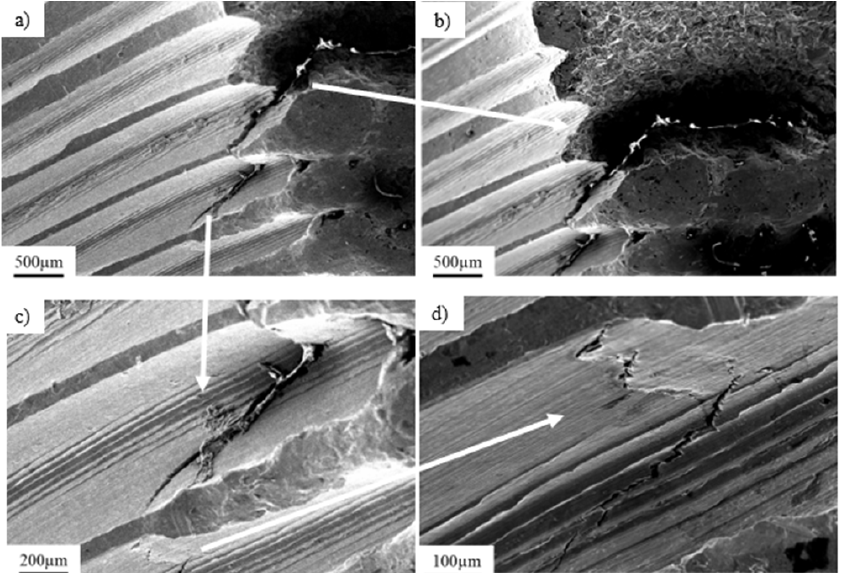
Figure 6. View of the dominant crack observed inside the thread ( a ), crack propagation from the thread surface ( b ), enlarged area of the crack initiation ( c ) and surface cracks observed near the dominant crack ( d ).